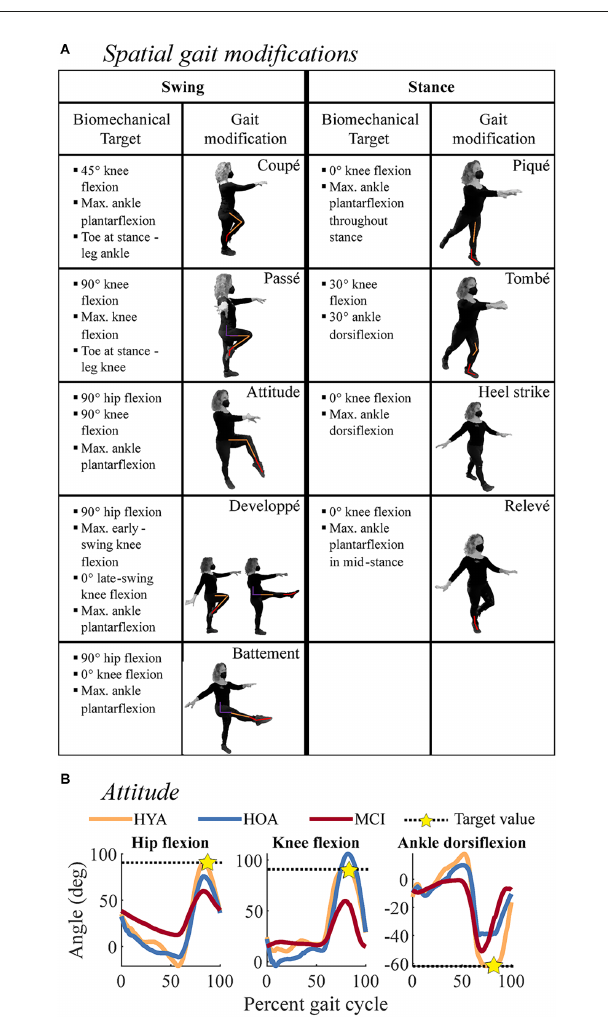
FIGURE1 Descriptions of subcomponents of the spatial gait modifications. or rhythmic movement sequences (RMS) evaluated in the current study. (A) Spatial gait modifications were derived from ballet steps, noted in the boxes containing movement depictions. The left two columns correspond to swing-phase modifications, while the right two columns correspond to stance-phase modifications. Each depiction shows the modification where biomechanical targets were applied. Colored lines on each person denote biomechanical targets at the hip (purple), knee (orange), and ankle (red) kinematics that were used to evaluate movement performance. Bulleted lists describe the biomechanical targets for each gait modification, which were used to quantify movement performance. Bullets denote the biomechanical targets for each gait modification. Modifications were performed in pairs during spatial trials. (B) Example of biomechanical targets for the Attitude gait modification. Black dashed lines denote biomechanical target values and gold stars denote where the target value was estimated. For example, during the Attitude modification, the swing-leg hip (left) and knee (middle) should be flexed to 90 degrees, and the ankle (right) should be maximally plantarflexed. Colored lines denote exemplary HYA (orange), HOA (blue), and MCI (red) participants. These participants highlight reduced RMS performance at the hip and knee in MCI and at the ankle in HOA and MCI.